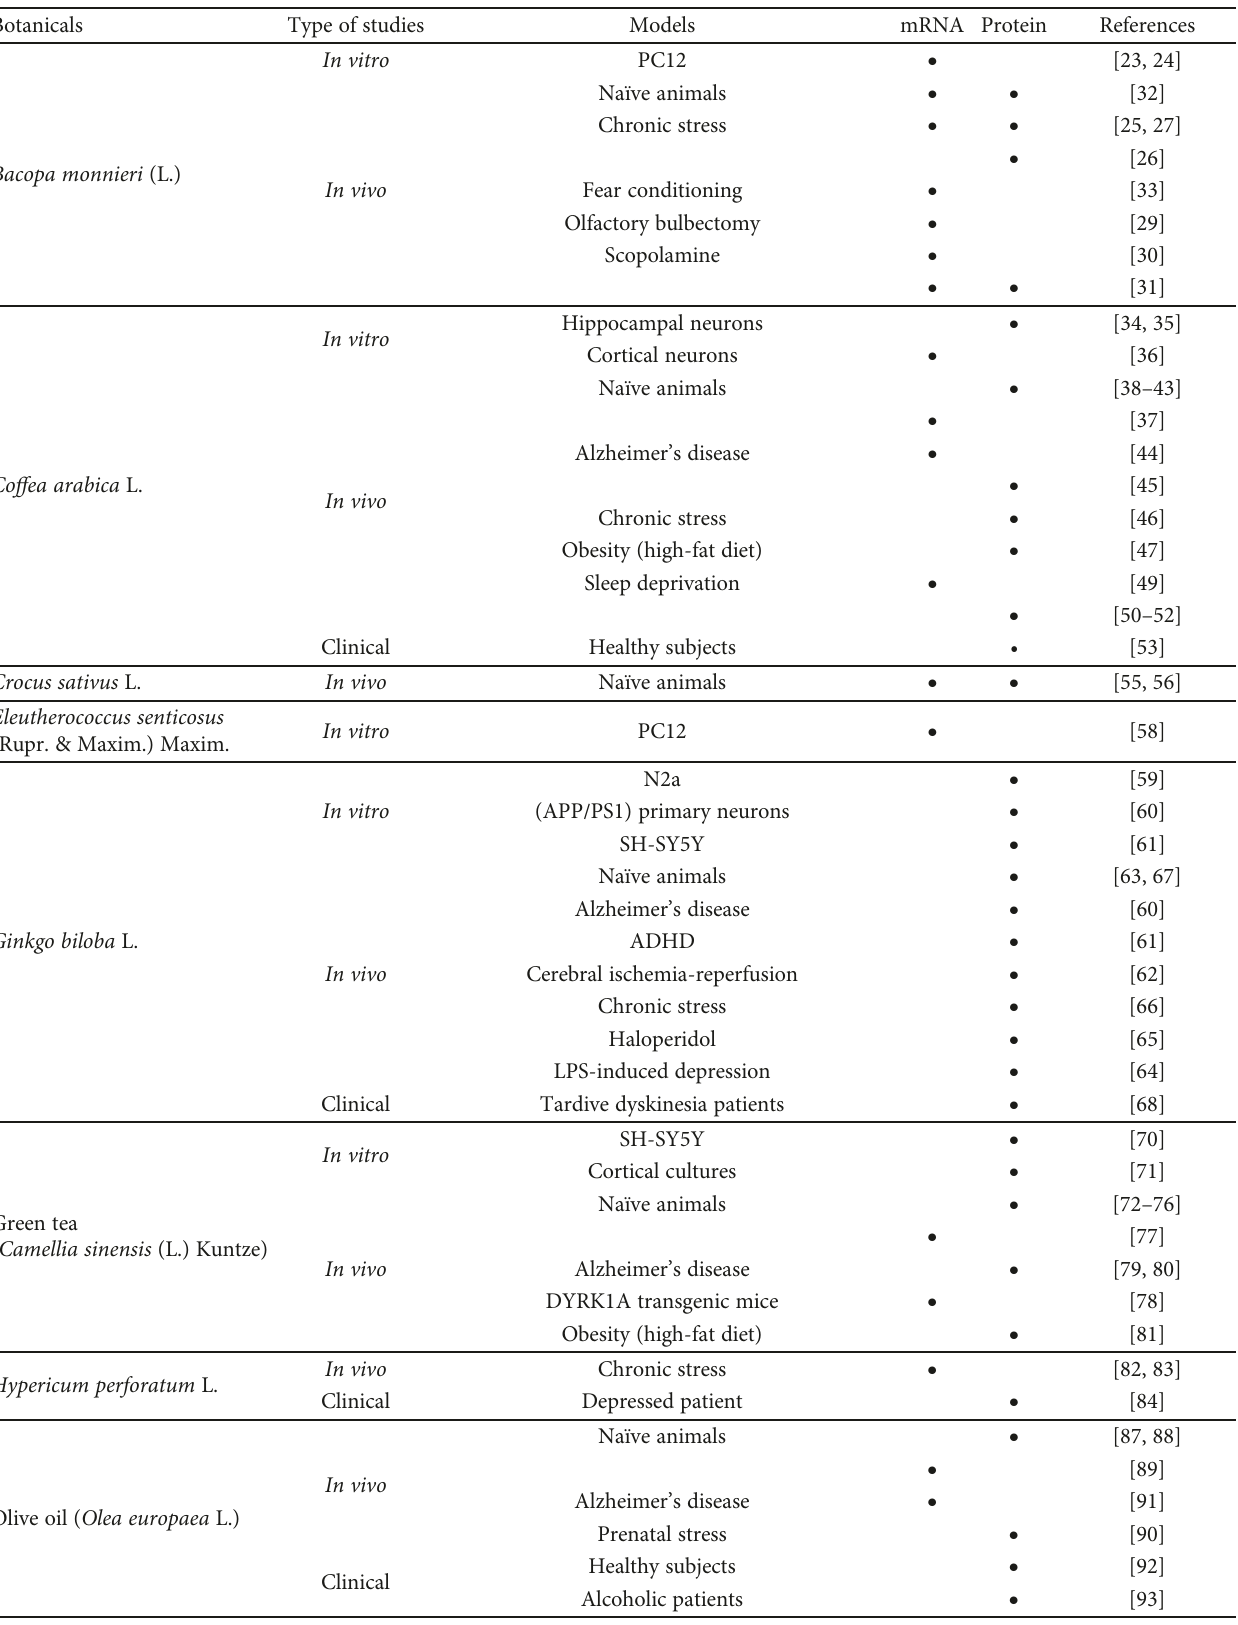
Table 2: Summary of the experimental conditions employed to investigate the e ff ect of botanical administration on BDNF expression. Botanicals